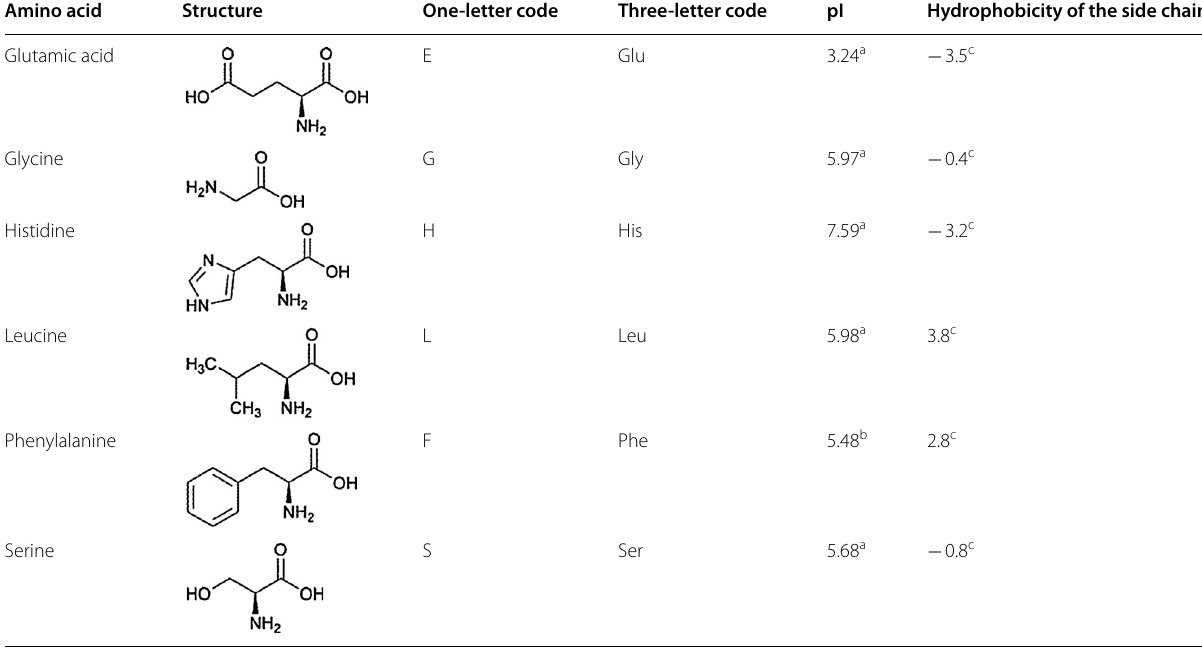
a Taken from Hardy (1985) b Taken from Jakubke and Jeschkeit (1982) c Taken from Kyte and Dolittle (1982)